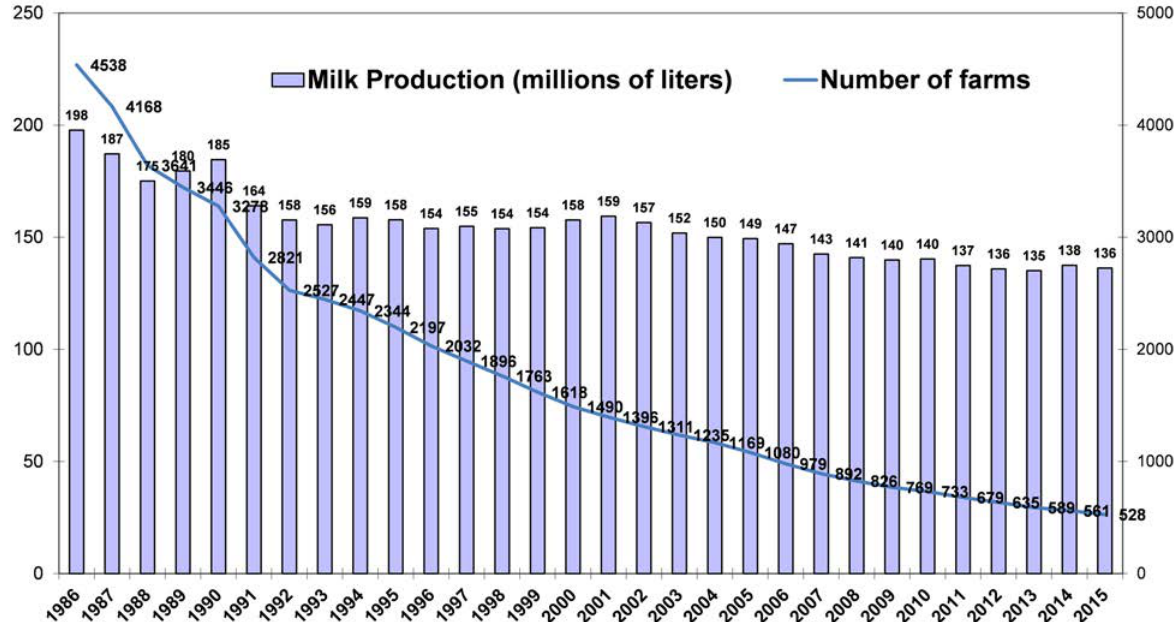
Fig. 3. Number of dairy farms and amount of milk production in North Karelia, 1986–2015. Source: Pro Agria 2016.